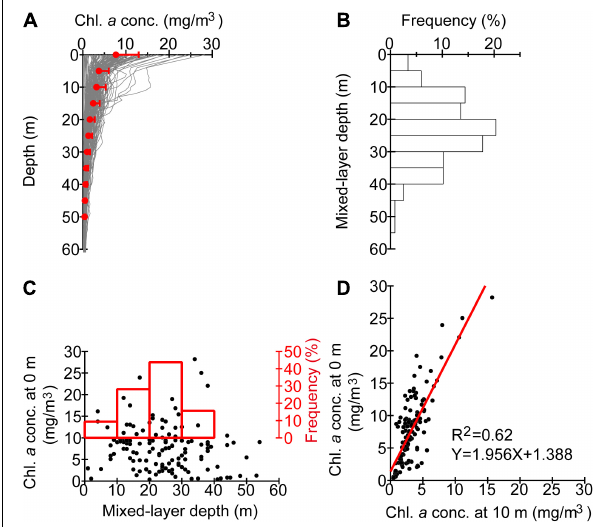
FIGURE 6 | (A) Profiles of chlorophyll- a concentrations based on conductivity–temperature–depth (CTD) measurements. Bin-averages and standard deviations are indicated by closed red circles and horizontal bars, respectively. (B) Frequency distribution of mixed-layer depths based on CTD measurements. (C) The same as Figure 5 , but for chlorophyll- a concentrations as a function of mixed-layer depths at CTD stations. (D) Scatter plots of chlorophyll- a concentrations at 0 versus 10 m at CTD